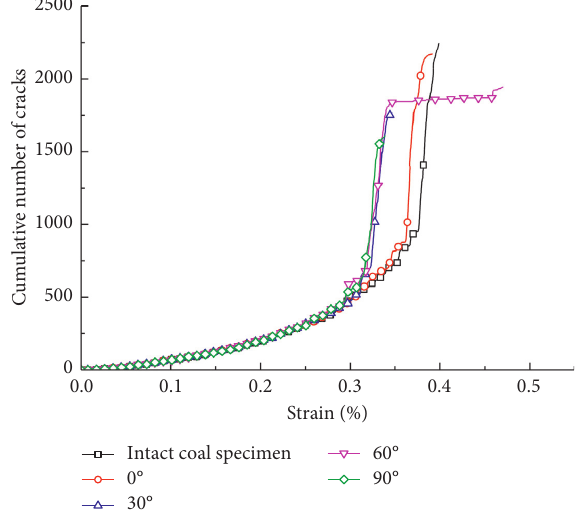
Figure 15: Curve of crack number and